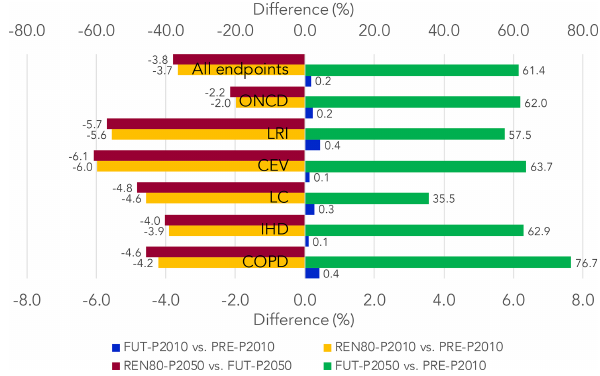
Figure 15. Relative differences (in PD/100000 inhabitants) be- tween the different scenarios for all the endpoints included in this work. FUT-P2010, FUT-P2050 and REN80-P2010 are compared to the PRE-P2010 scenario, while the differences for the REN80- P2050 scenario are estimated with respect to the FUT-P2050 sce-